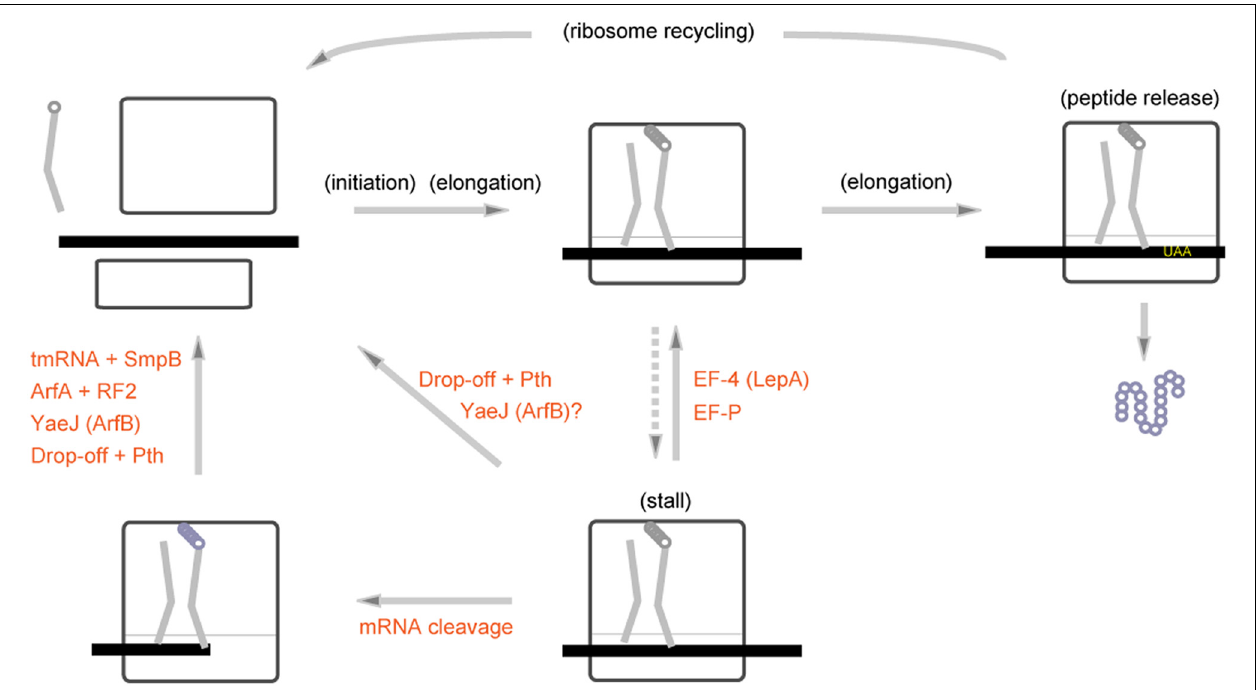
FIGURE 5 | Multiple pathways to rescue the bacterial stalled ribosome. Various kinds of mechanisms rescue the stalled ribosome in bacterial cells. Some types of stalled ribosomes are rescued by EF4 (LepA) or EF-P, which facilitates resumption of elongation process. The stalled ribosome with a short nascent peptide can be rescued by